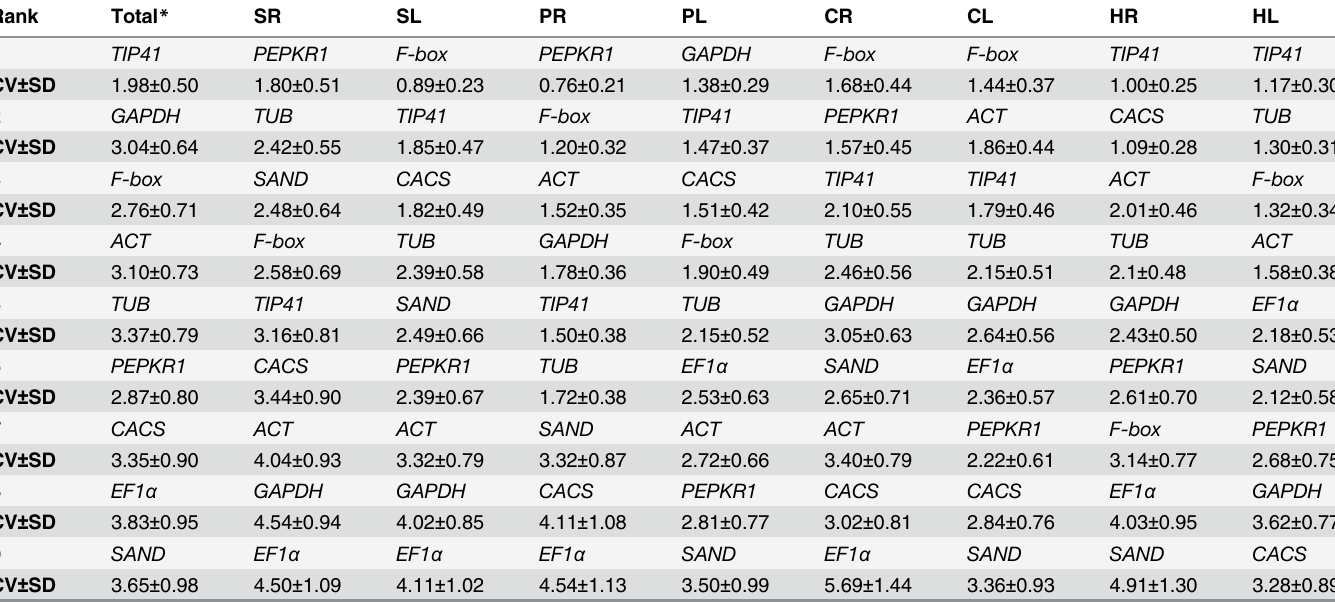
Table 4. Stability analysis of reference genes assayed by BestKeeper